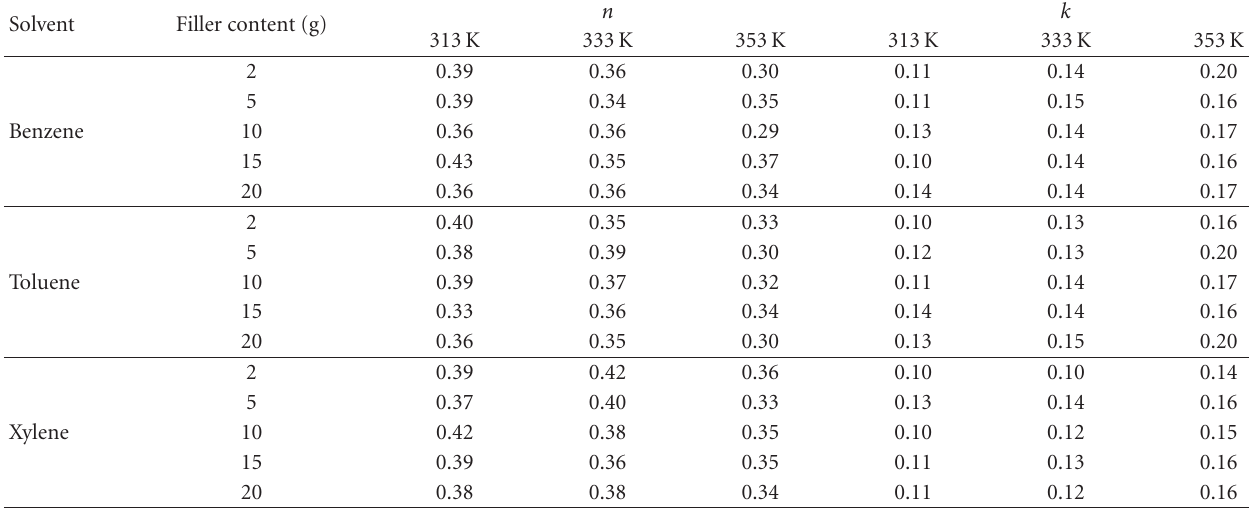
Table 10: Values of n and k of snail shell powder filled natural rubber at di ff erent temperatures (filler particle size, 0.300 μ m). Solvent Filler content (g)